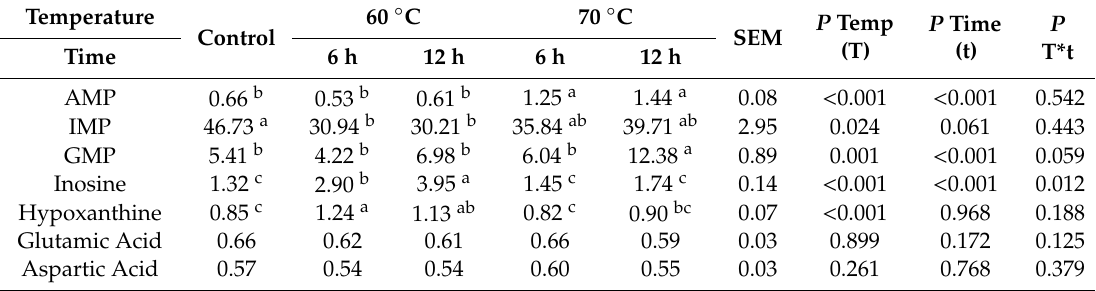
Table 4. 5’-nucleotides (AMP, IMP, GMP, inosine, and hypoxanthine, g / 100 g) and free amino acids (glutamic and aspartic acid, g / 100 g) of beef semitendinosus heated at di ff erent temperatures and times.